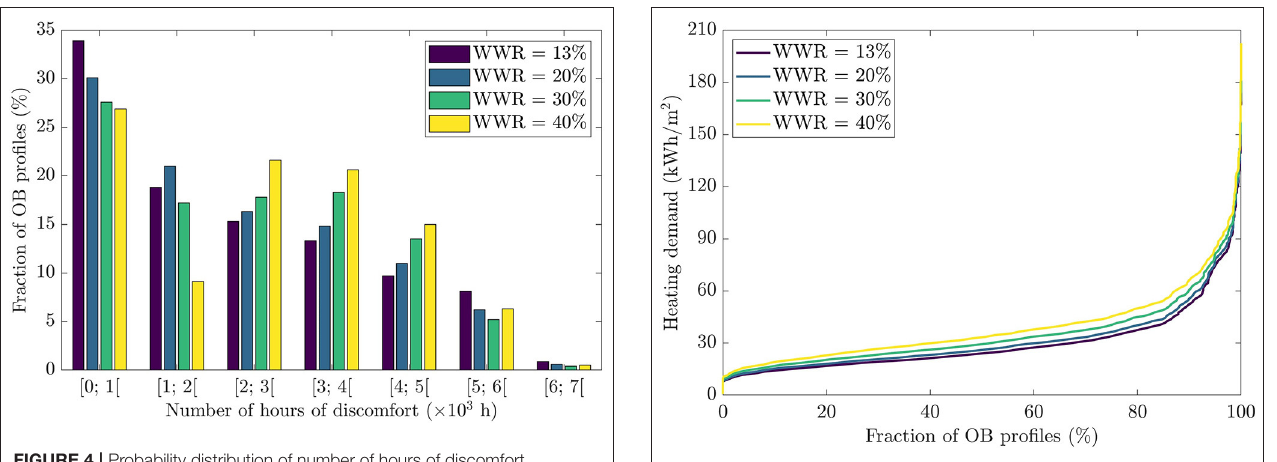
FIGURE 5 | Cumulative fraction of possible occupant behavior scenarios with a specific heating demand. representing different WWRs never cross, which means that a 13% WWR has lower heating demand even for the 10% of scenarios that generated the most heating demand. This is also reflected in Table 2 , where the 95th centile value is 75 kWh/m 2 for the 13% WWR dwelling vs. 85 kWh/m 2 for the 40% WWR. The standard deviation is also smaller with 13%